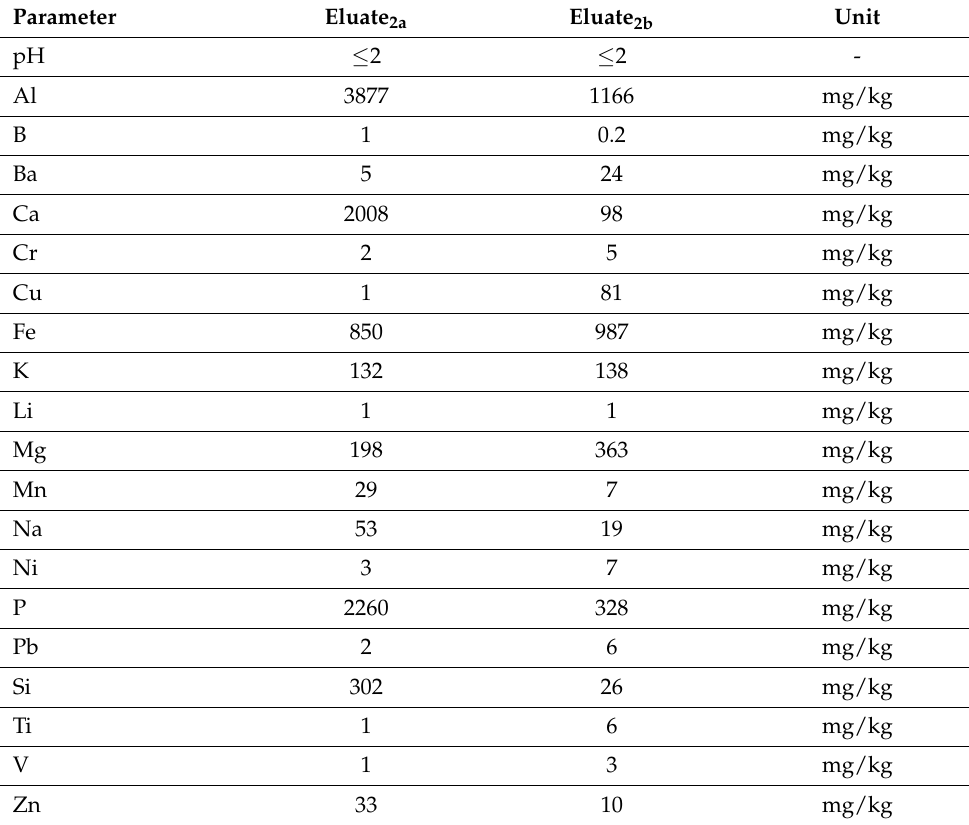
Table 13. Characterization of case 2 eluate from step a (eluate 2a ) and step b (eluate 2b